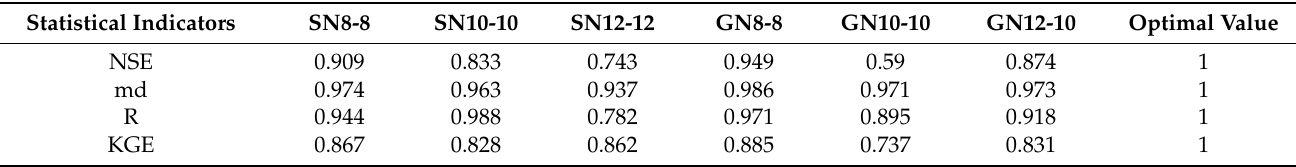
Table 4. Results of statistical